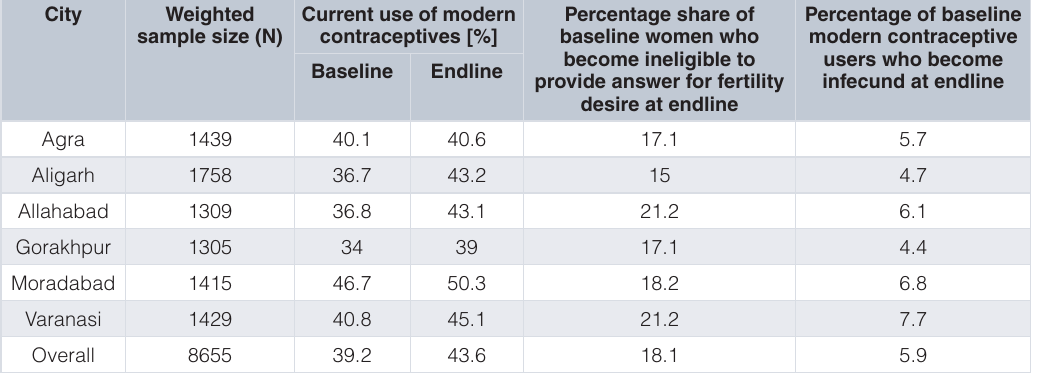
Table 1. City-wise percentage distribution of women using modern contraceptive methods.